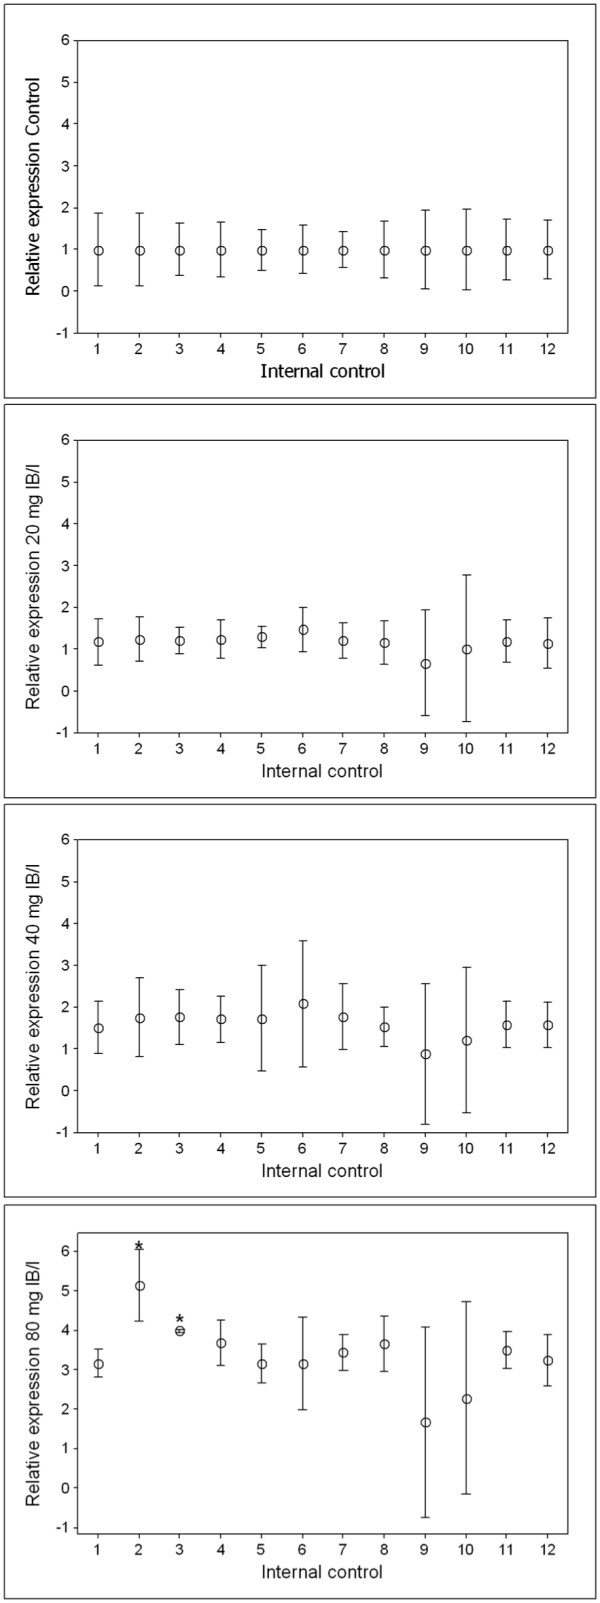
Relative gene expression of target gene Ltb4dh in Daphnia magna following a 24 h exposure to ibuprofen. Mean relative expression (n = 3) ± SD of Ltb4dh following normalisation to 10 candidate reference genes and a normalisation factor (NF). Expression levels are displayed relative to the mean control level. For comparison, the normalised relative expression of Ltb4dh is displayed by treatment group. Relative expression of Ltb4dh normalised to: Act (1); Atb (2); Cyp (3); GAPDH (4); SDH (5); TBP (6); WARS (7); UBC (8); 18S (9); 28S (10); NF3 based on the geometric mean of Act, GAPDH and UBC (11); and Ltb4dh without normalisation (12) (gene name abbreviations as Table 1). An asterisk (*) indicates a significant difference (p < 0.05) from Ltb4dh normalised by NF3.